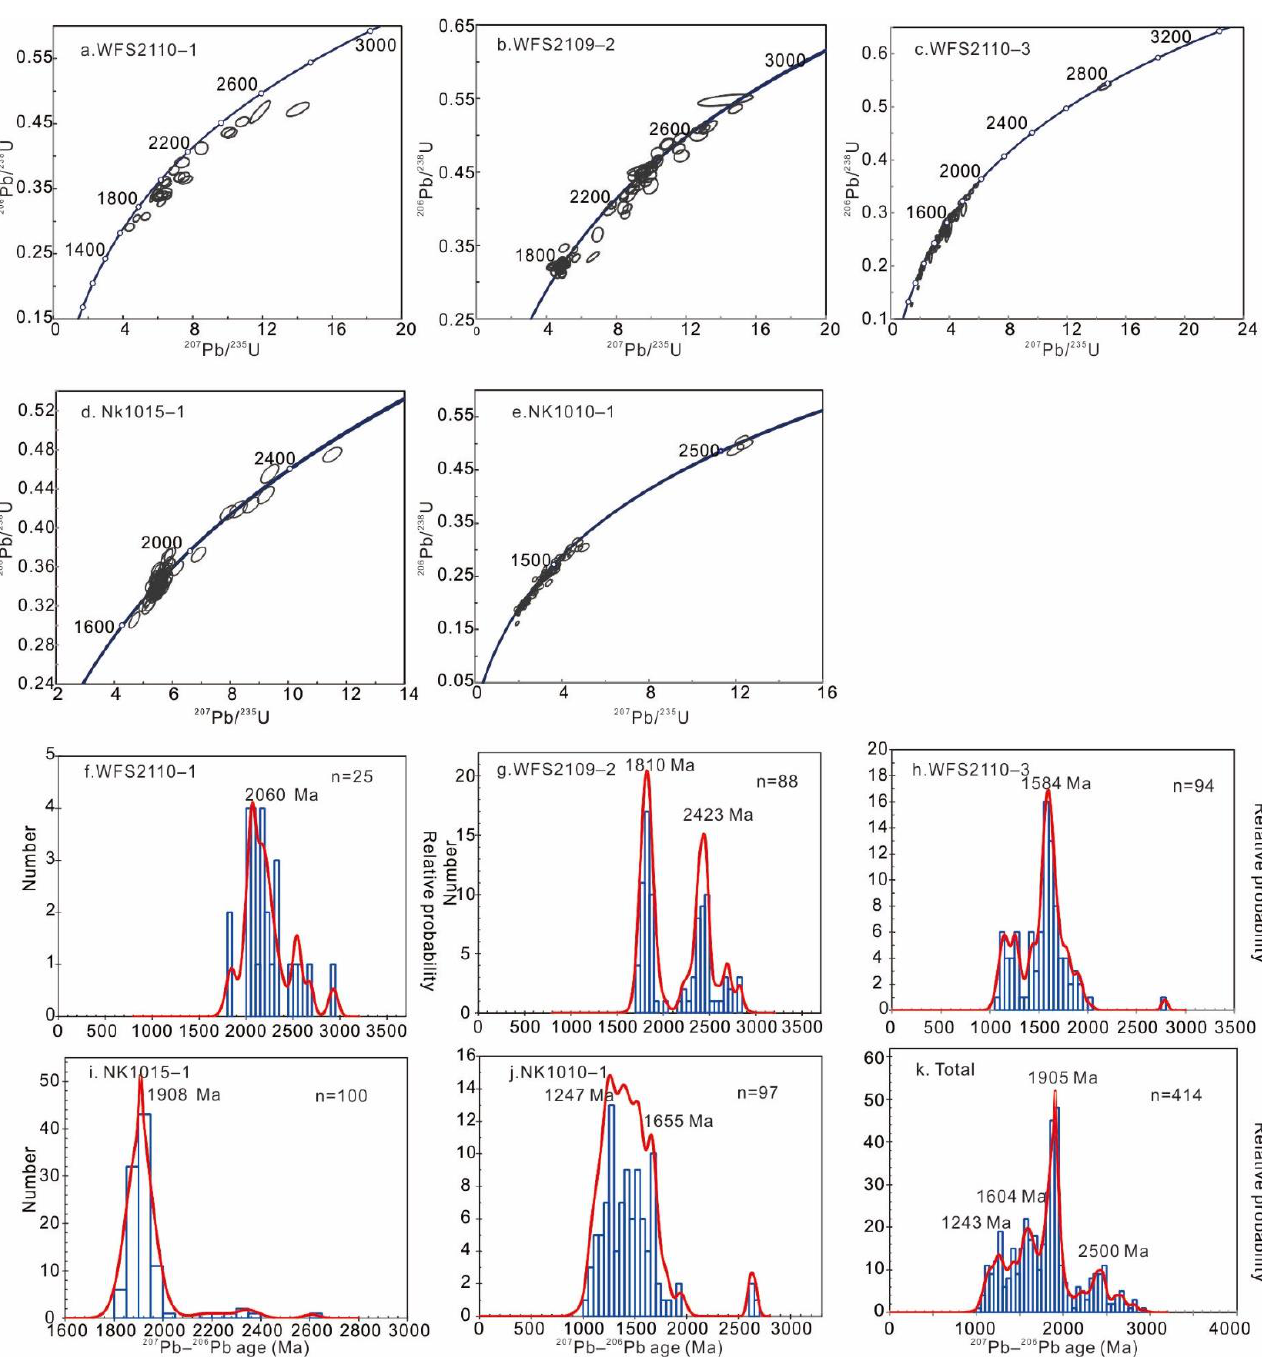
Figure 6. U – Pb concordia and relative probability plots of detrital zircons of the samples from the target successions. Ages are in Ma and ellipses show 1σ errors.